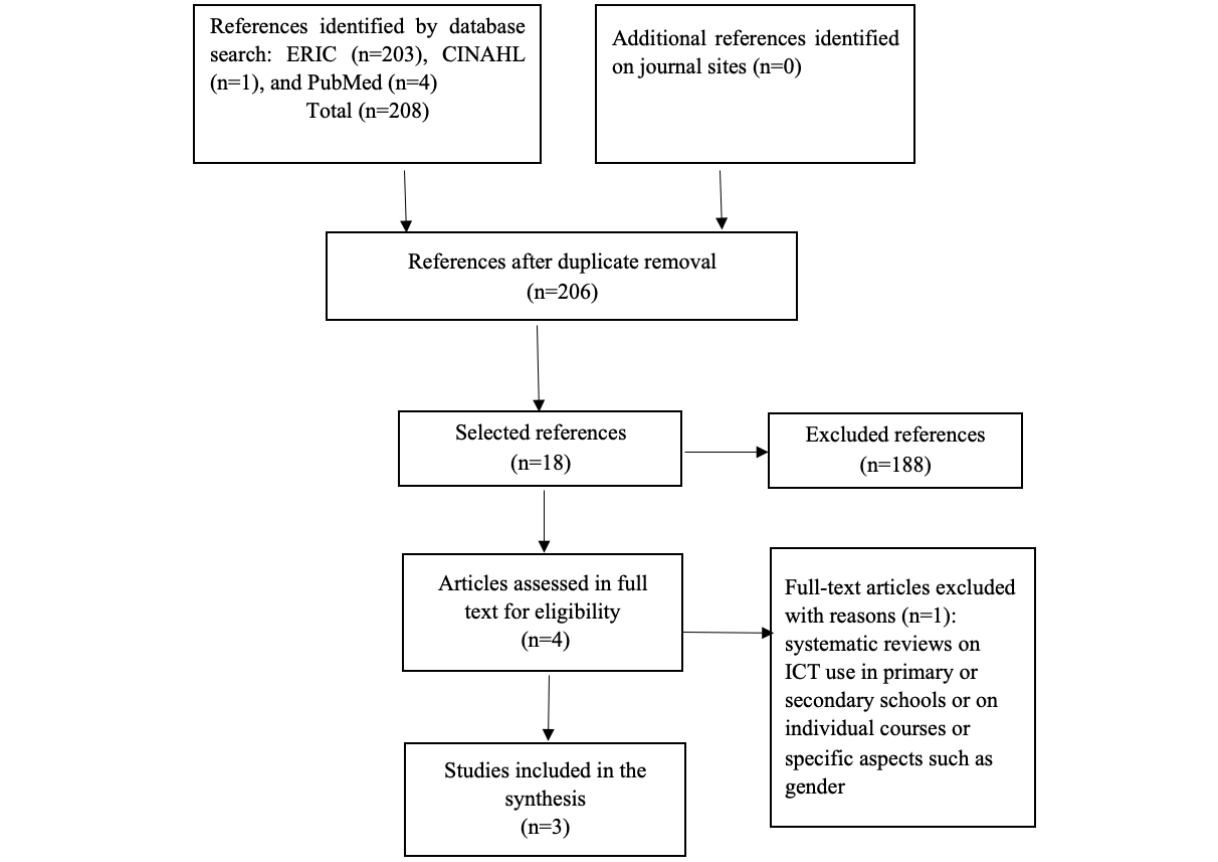
Figure 1. Adapted PRISMA (Preferred Reporting Items for Systematic Review and Meta-Analysis Protocols) flow diagram to show the results of the searches in the first literature review. ICT: information and communications